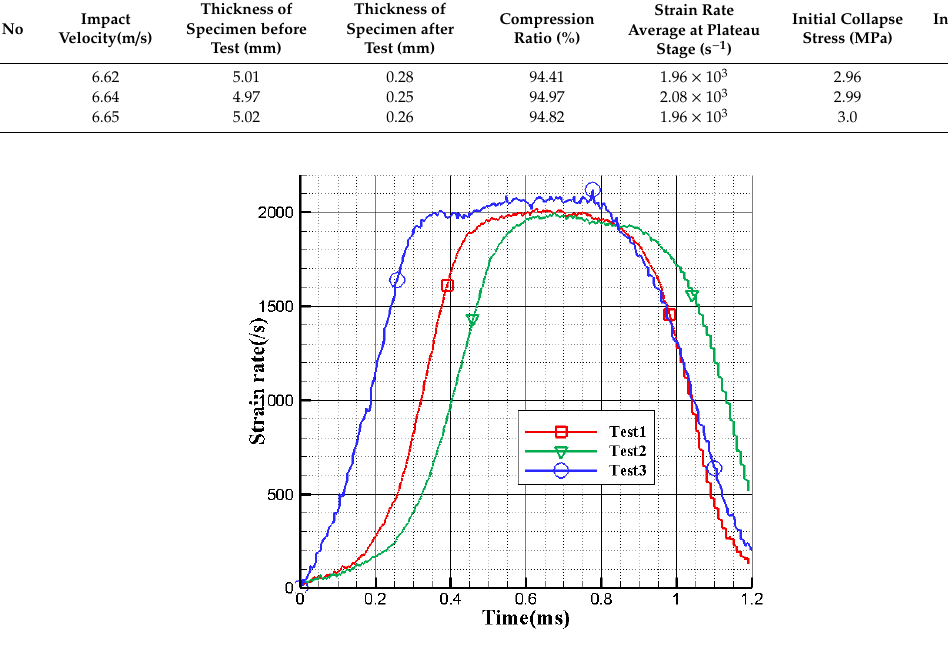
Figure 12. Stress–strain curve at strain rate 2.0 × 10 3 s - − 1 .